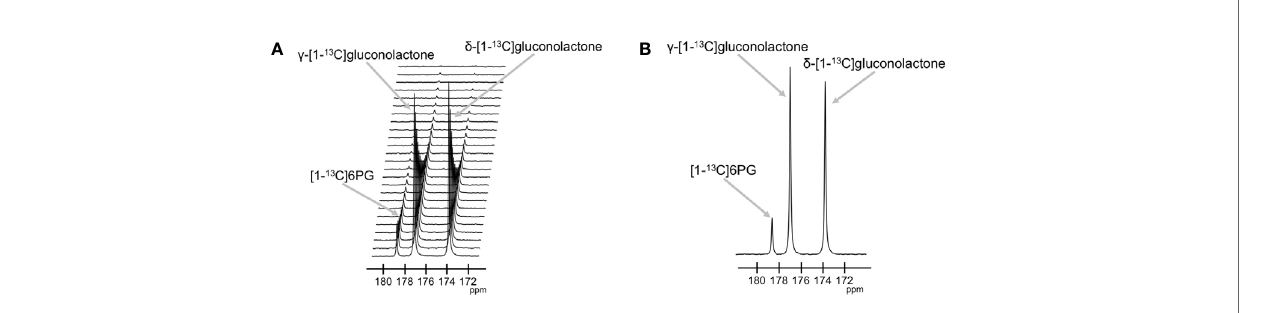
FIGURE 4 | Hyperpolarized d -[1- 13 C]gluconolactone metabolism to [1- 13 C]6PG can be observed in live glioblastoma cells. (A) Representative 13 C MR spectral array showing dynamic production of [1- 13 C]6PG from hyperpolarized d -[1- 13 C]gluconolactone in live U87 cells. Peaks for d -[1- 13 C]gluconolactone, g -[1- 13 C] gluconolactone and [1- 13 C]6PG can be observed. (B) Summed 13 C MR spectrum showing [1- 13 C]6PG production from hyperpolarized d -[1- 13 C]gluconolactone in live